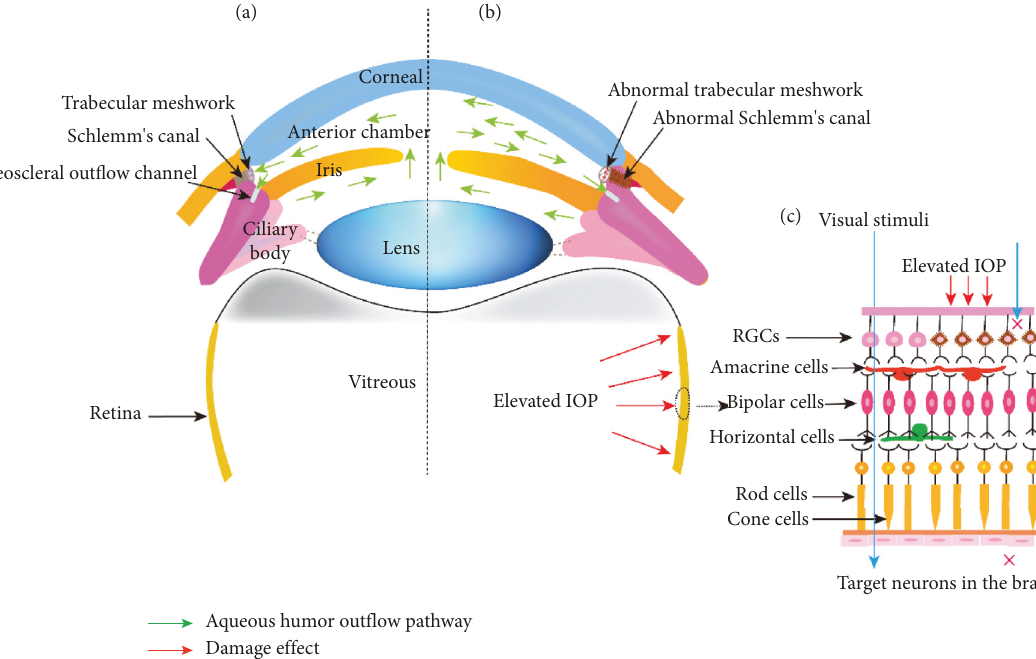
Figure 1: Schematic diagram of the circulation of aqueous humor. (a) Normal aqueous humor circulation. The aqueous humor is drained mainly through the conventional outflow channel (mainly composed of trabecular meshwork and Schlemm’s canal) and the uveoscleral outflow channel. (b) Abnormal anterior chamber angle. In primary congenital glaucoma patients, dysplastic trabecular meshwork and Schlemm’s canal impaired aqueous humor outflow. Obstruction of the aqueous humor outflow leads to a continuous increase in intraocular pressure. (c) Elevated intraocular pressure affects retinal nerve function. Persistently elevated intraocular pressure leads to optic nerve damage, which eventually causes the death of retinal ganglion cells and disrupts the propagation of visual stimuli to target neurons in the brain. IOP: intraocular pressure; RGCs: retinal ganglion